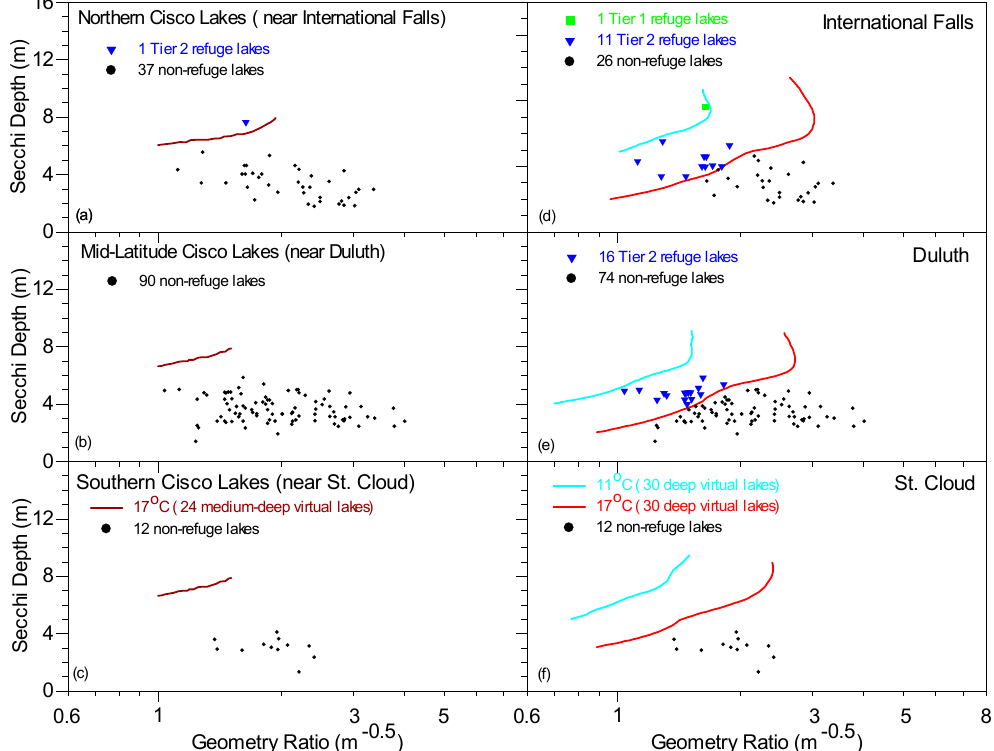
Figure 10. Distribution of Tier 1 and Tier 2 refuge lakes, and Tier 3 non-refuge lakes out of 140 medium-deep cisco lakes using Secchi depth and lake geometry ratio as axes. The boundary contour lines of AvgATDO3 VB were derived from variable benchmark periods simulated for: the 24 medium- deep virtual lakes ( a – c ); and the 30 deep virtual lakes ( d – f ), under MIROC 3.2 future climate scenario. International Falls ( a , d ), Duluth ( b , e ), and St. Cloud ( c , f ) weather data were used for the model simulations.